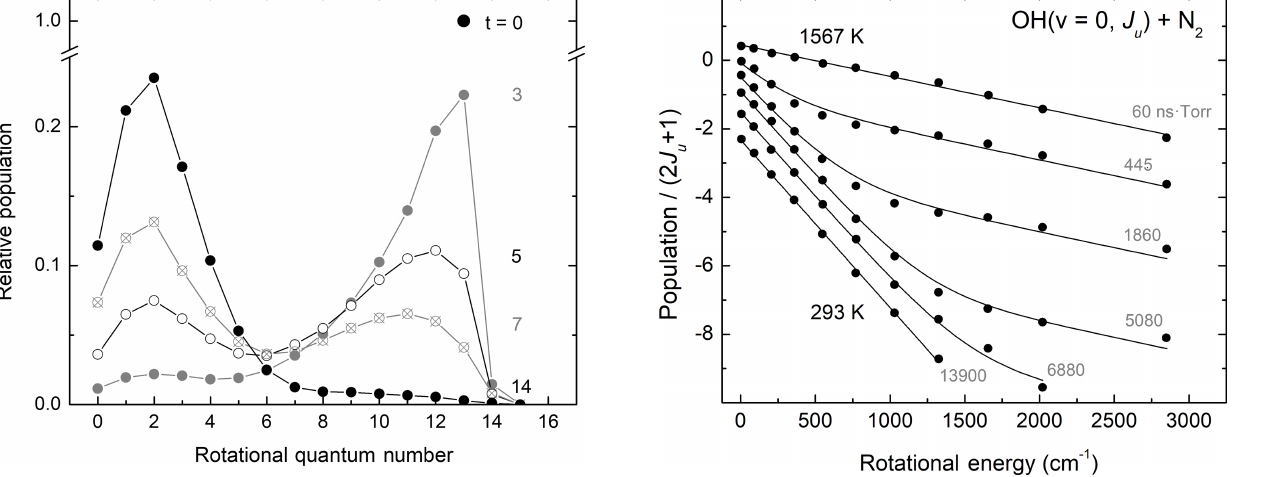
Figure 3. Experimental results (circles) of Kliner and Far- row (1999) for rotational relaxation of OH( v = 0, N = 1–12) col- liding with N 2 bath gas and fits to single-temperature and two- temperature Boltzmann distribution functions. The two character- istic temperatures represent the initial OH distributions and the fi- nal fully thermalized gas. The relative weight of the two Boltzmann distributions changes as the relaxation process evolves in time. The grey labels show the product time × pressure corresponding to the experimental